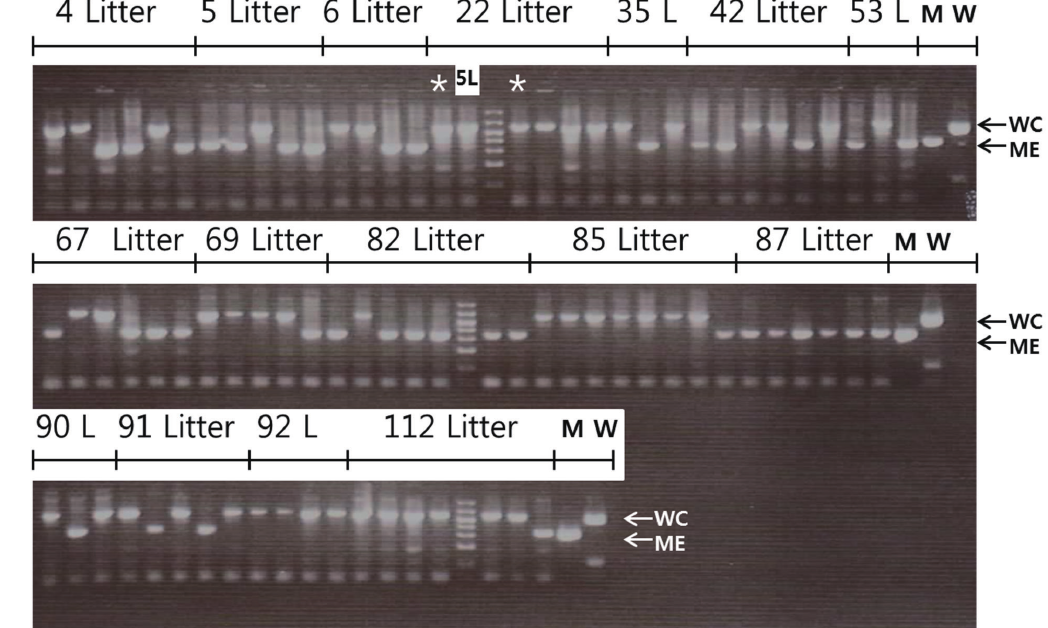
Figure 2. Confirmation of the breeds of origin of X chromosome by polymorphism in the intron 20 of porcine O-linked N-acetylglucosamine transferase (OGT). When boars produced by inter se mating of 1/2 Meishan (ME)×1/2 White composite (WC) parents, the breed of origin of X chromosome quantitative trait locus (QTL) was confirmed by the length polymorphism due to the presence of the inserted element in the intron 20 of OGT after polymerase chain reaction amplification. Out of 84 boars of 16 litters (L) analyzed, boars from 13 litters had both ME and WC alleles. They included ‘4, 5, 6, 35, 42, 53, 67, 69, 82, 85, 90, 91, and 112’ litters. Boars from the ‘22’ and ‘92’ litters had only WC allele, while boars from the ‘87’ litter had only ME allele. One of the ‘5’ litter (5L) boar was placed among the ‘22’ litter boars. Two boars (*) with ambiguous origin of X chromosome QTL from the ‘22’ litter were confirmed as having WC allele.